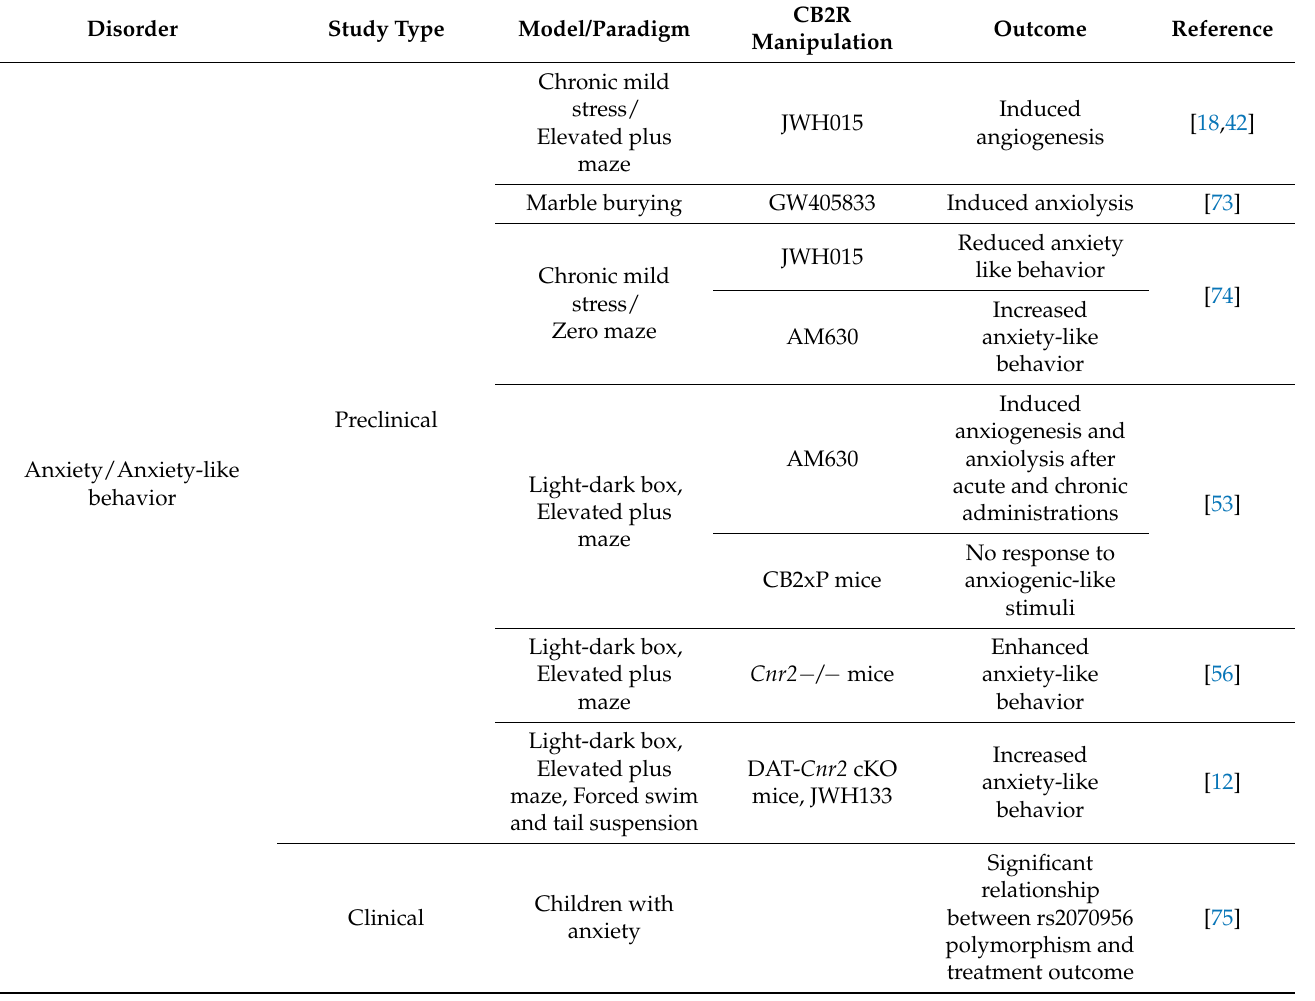
Table 1. CB2 cannabinoid receptors in neuropsychiatric